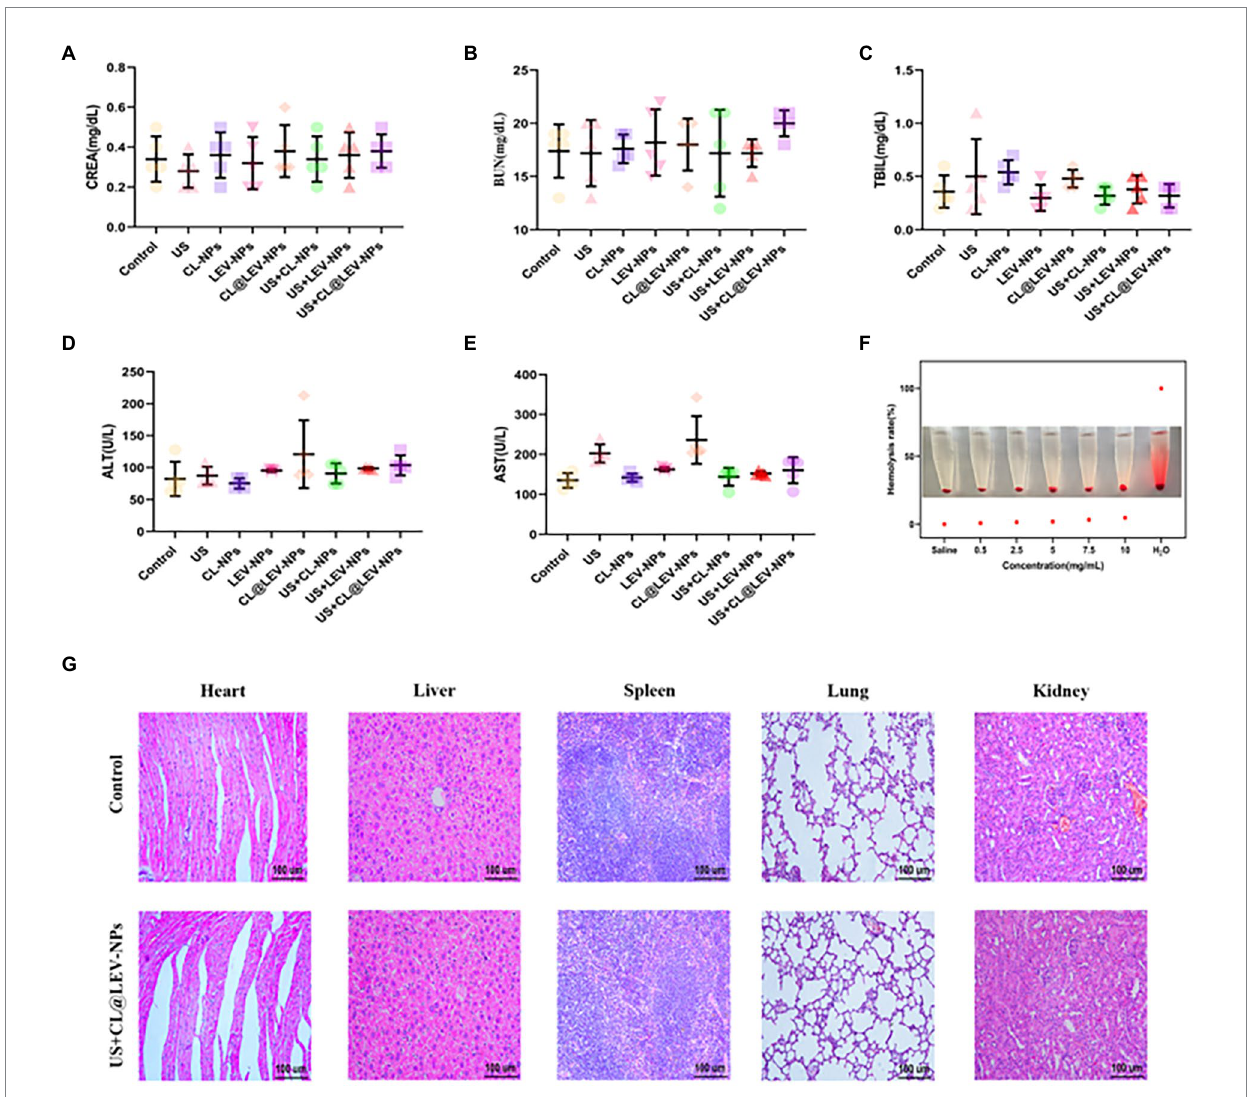
FIGURE 11 In vitro and in vivo biosafety evaluation. (A) serum CREA, (B) BUN, (C) TBIL, (D) ALT and (E) AST indices of BALB/c mice after 12 days of treatment; (F) Hemolysis assay; (G) H&E staining images of major organs of BALB/c mice after intravenous